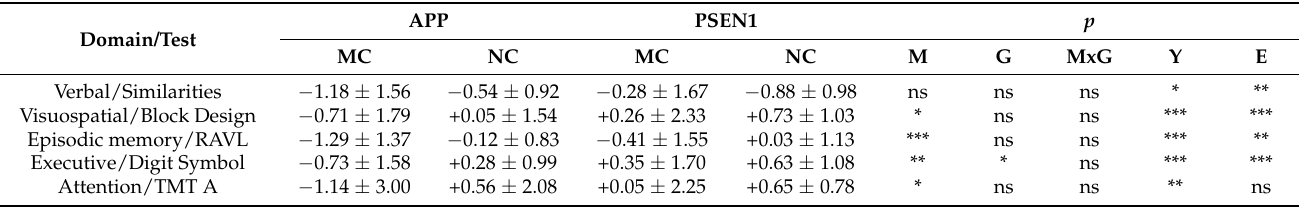
Table 2. Cognitive test results (Mean ± SD) in z ‐ score based on normal individuals in mutation carriers (MC) and non ‐ carriers (NC) from APP and PSEN1 families. ANCOVA p ‐ values are reported as well as related to mutation status, gene, mutation–gene interaction and the effects of covariates (YECO and years of education).